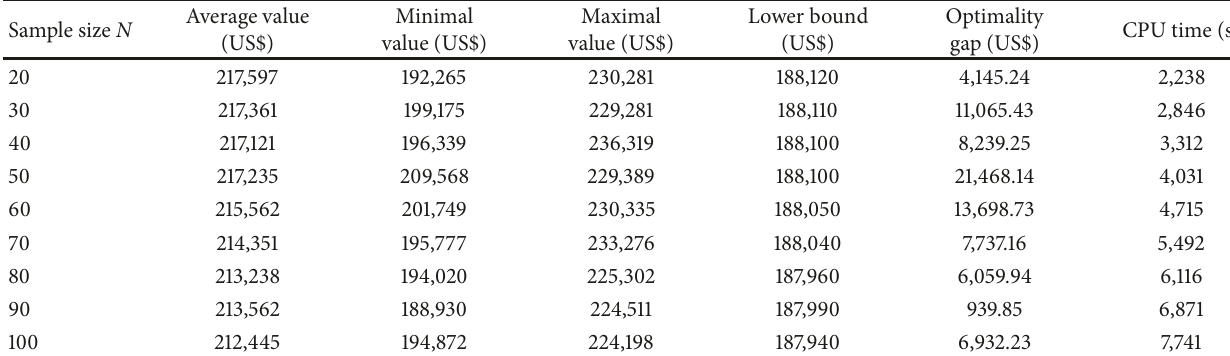
Table 9: The results of SAA with 𝑀 = 20 and 𝑁 󸀠 = 1000